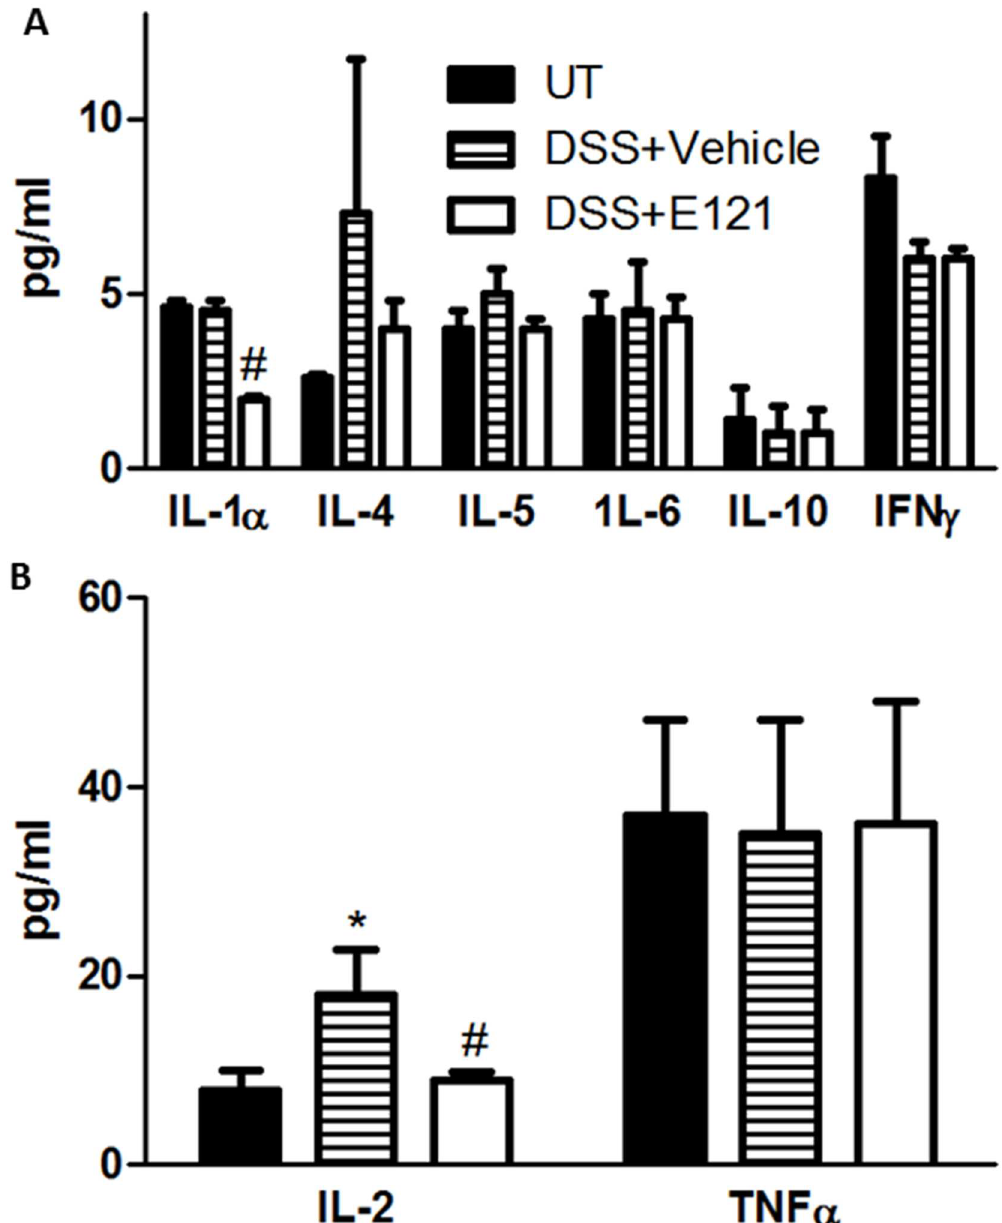
Fig 3. Effect of E121 treatment of circulating levels of various cytokines. Plasma levels (pg/ml) of various cytokines were measuredin UT mice (solid bars), or mice treated with DSS plus vehicle(hatchedbars) or E121 (60 mg/kg, open bars). Histobars representmeans ± SEM for 4 mice in each group. Asterisk denotessignificant difference from UT mice, with p < 0.05,and # denotessignificantdifference from DSS/ i.p vehicletreated mice, with p <